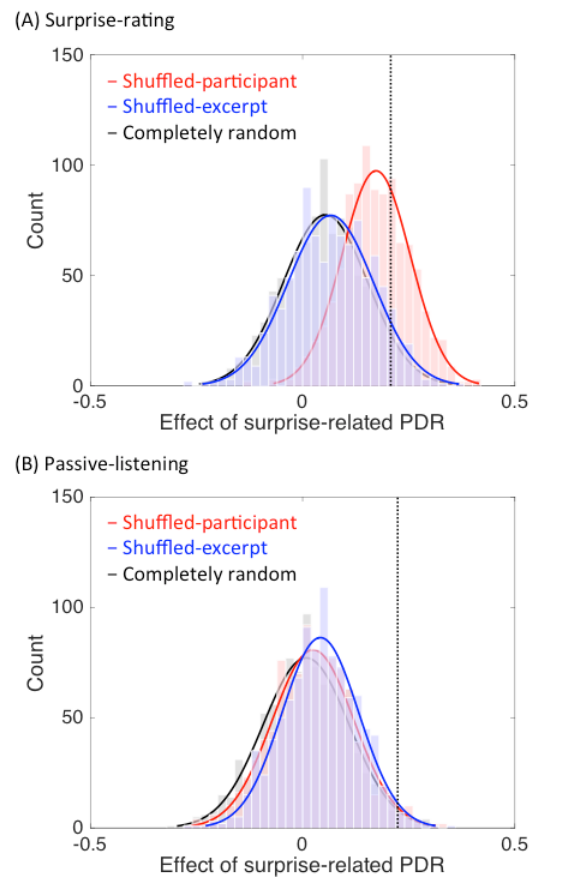
Fig. 4. Histogram of the estimated PDR-surprise associations in surprise-rating (A) and passive-listening (B) sessions. The curves represent the fitted normal densities. The vertical dashed lines indicate the observed surprise-related